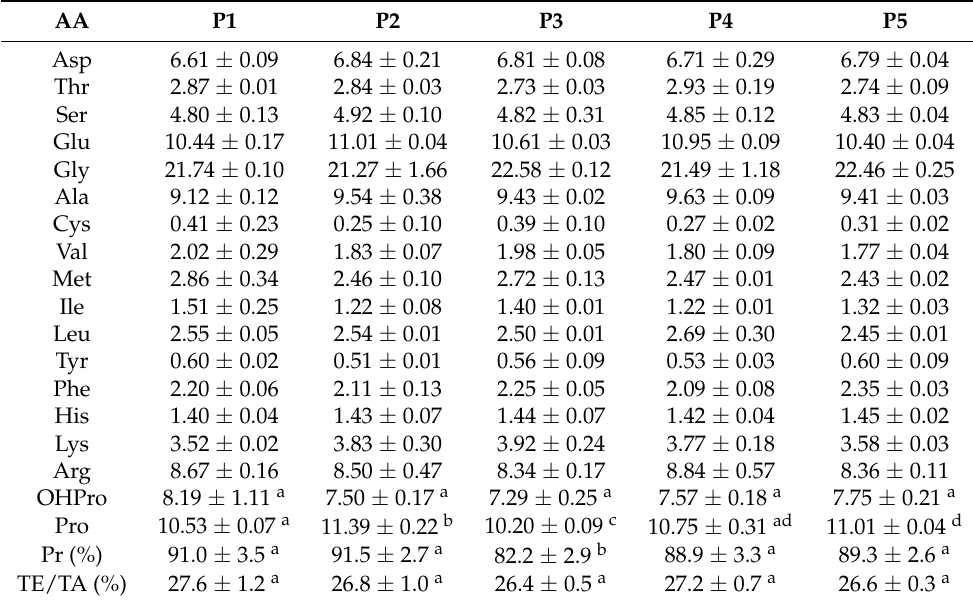
Table 4. Amino acid (AA) content of gelatins recovered from fresh salmon skins (% or g/100 g total amino acids) with each protocol of production. OHPro: hydroxyproline. Pr: % of protein present, as the sum of amino acids, in the extracted gelatin sample, and TE/TA: ratio total essential amino acids for human/total amino acids. Errors are the confidence intervals for n = 2 (replicates of independent batches) and α = 0.05. Different letters (a, b, c, and d) in each column (as superscript) mean significant difference between hydrolysates ( p <